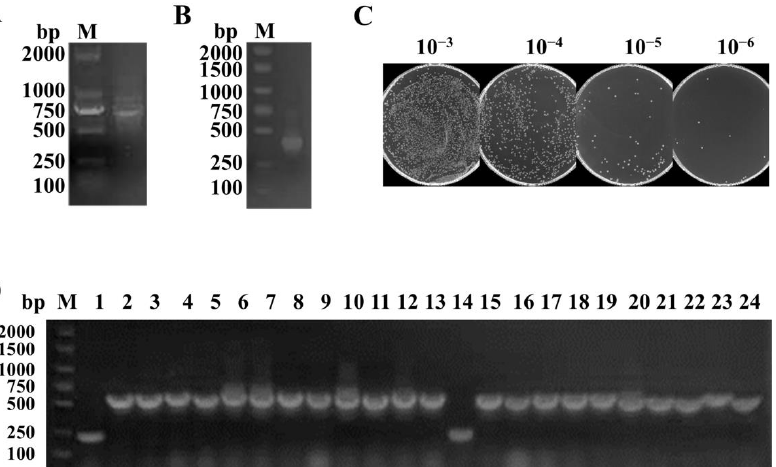
Figure 2. Construction of VHH library. ( A , B ) VHH genes were generated by a two-step nested PCR. ( C ) The library size was measured by counting the clone numbers using the gradient dilution method. ( D ) The correct insertion rate was estimated by randomly selecting 24 colonies and performing PCR. M: DNA marker DL 2000.